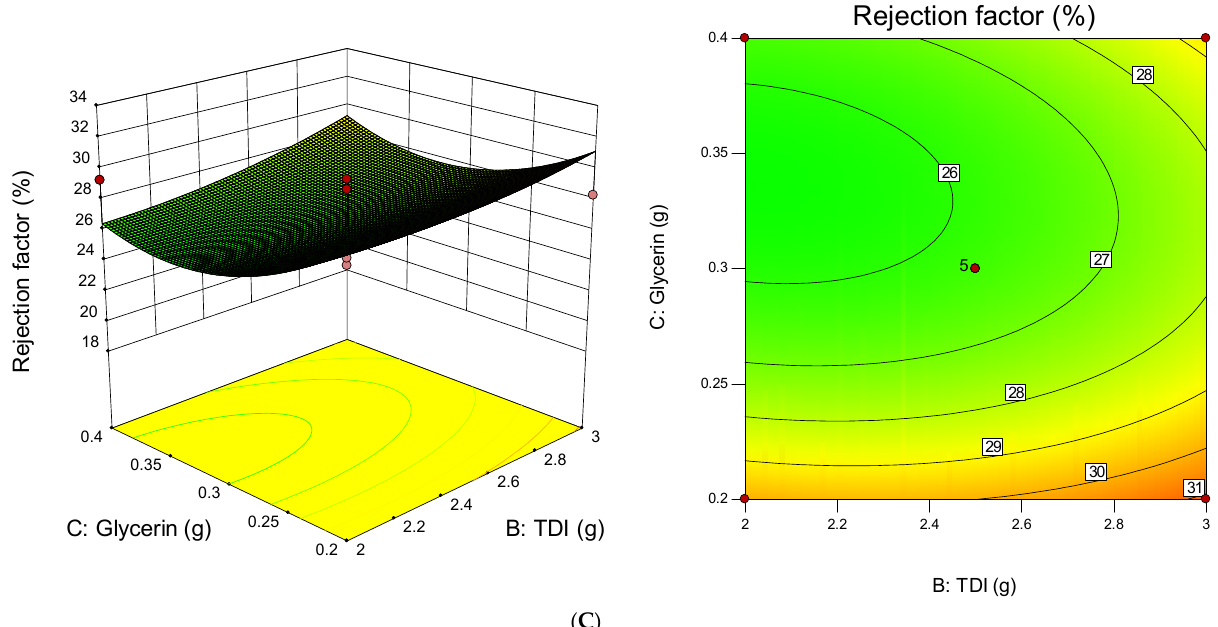
Figure 8. A 3D plot and surface plot of the relationship between ( A ) RSB and TDI to rejection factor, ( B ) RSB and Glycerin to rejection factor, and ( C ) TDI and Glycerin to rejection factor.